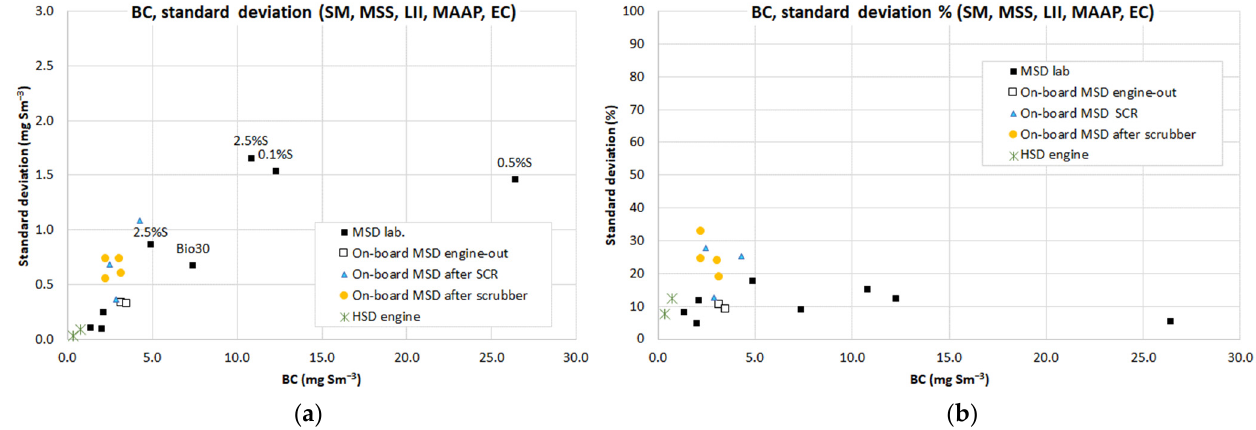
Figure 4. BC concentrations and their standard deviations when measured with different principles in three campaigns, ( a ) in absolute terms and ( b ) in relative terms. in three campaigns, ( a ) in absolute terms and ( b ) in relative